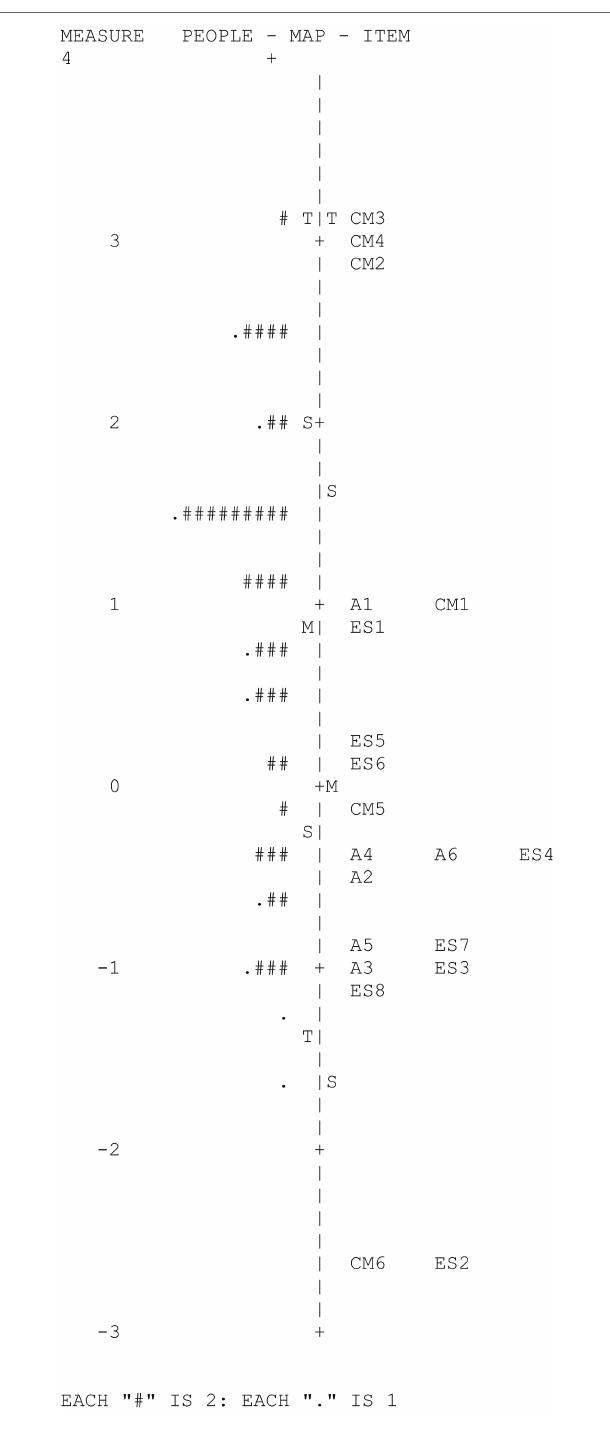
FIGURE 3 | CAPALIST-social thinking. Variable